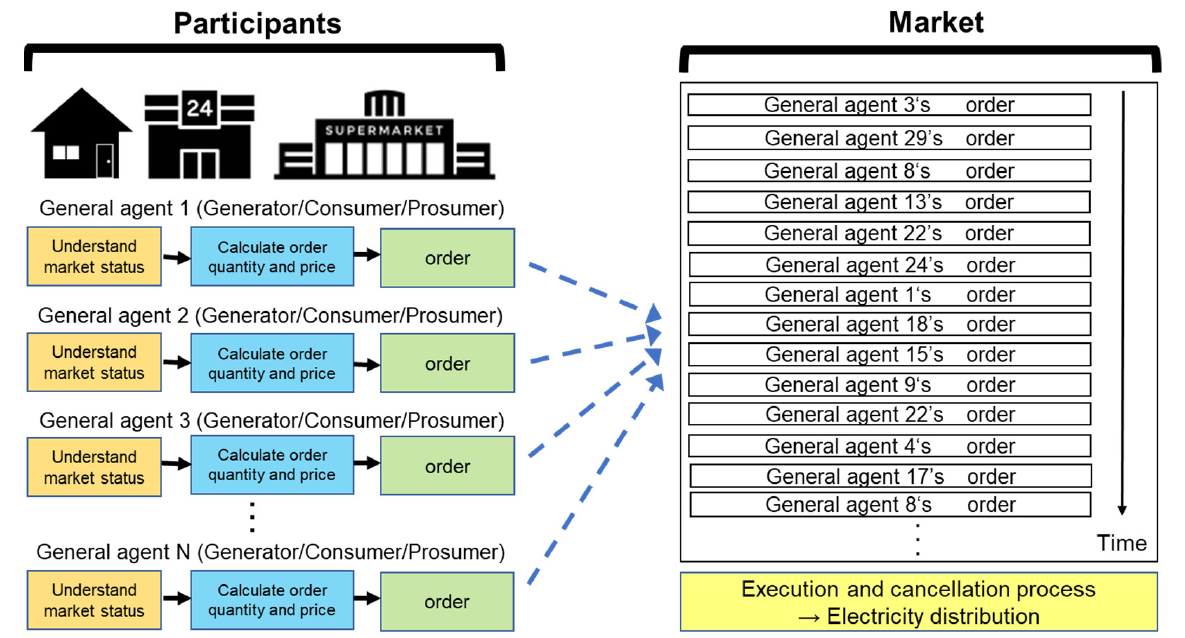
Figure 6. P2P electricity market before the introduction of market makers.